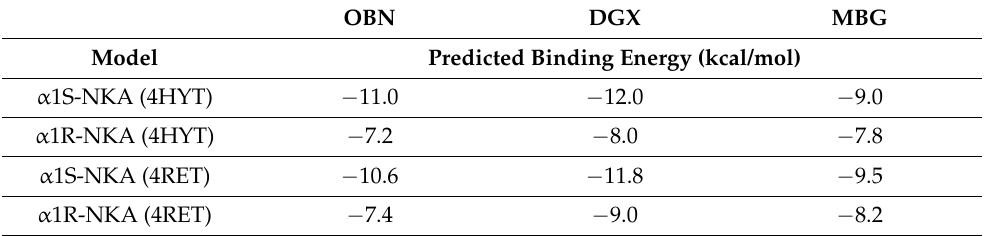
Table 3. Predicted binding energy of cardiotonic steroids with α 1S- and α 1R-Na,K-ATPase.